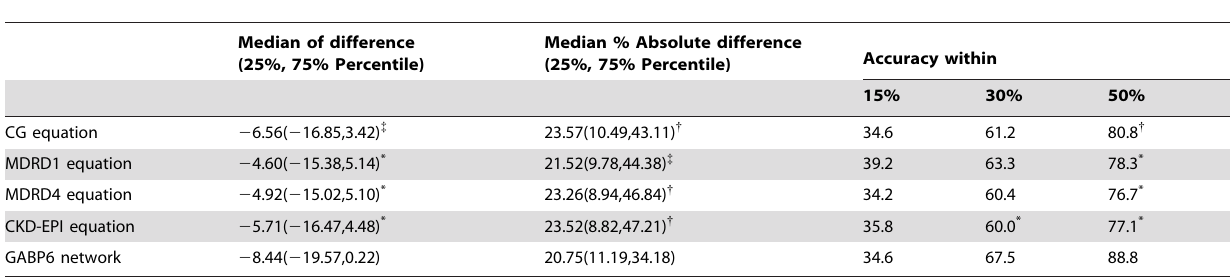
Table 6. Overall performance of difference and accuracy between eGFR and sGFR in the additional external validation data set.